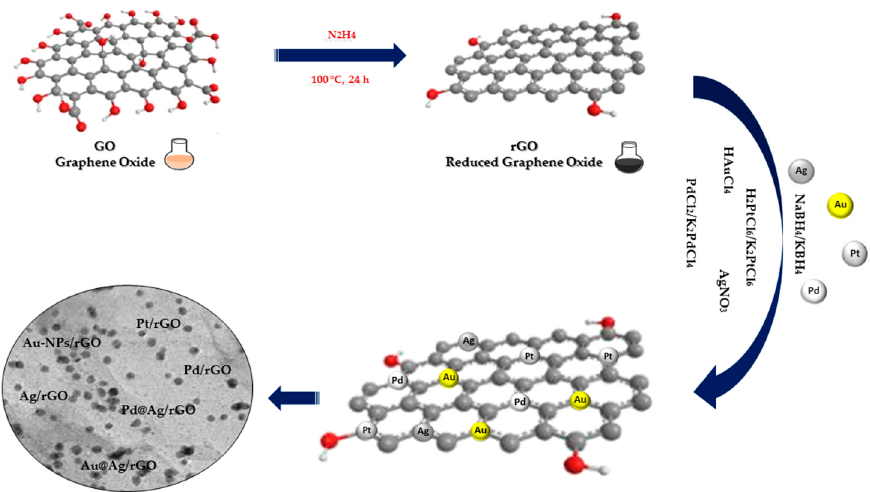
Figure 2. Chemical reduction synthesis of noble metal nanocomposites